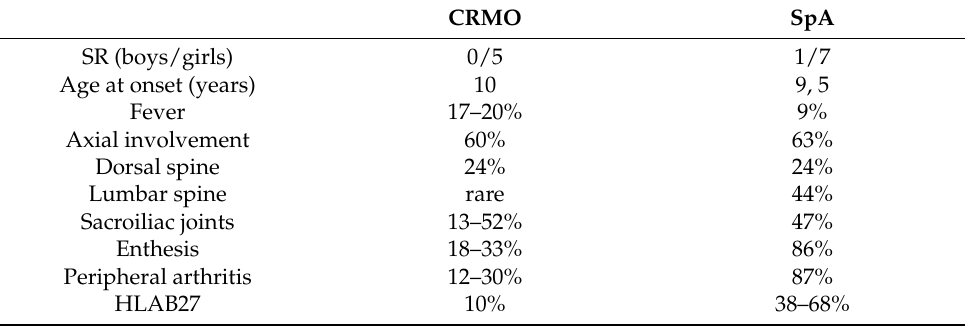
Table 1. Clinical characteristics of CRMO [23] and SpA [12,24].